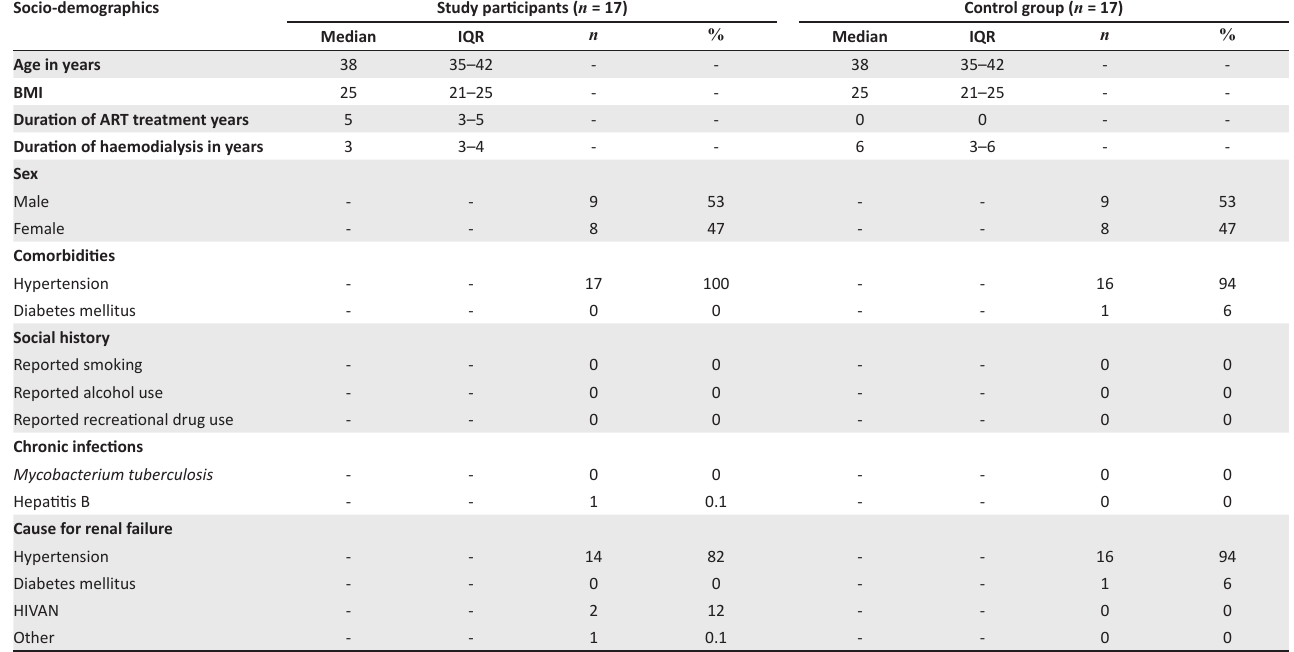
TABLE 2: Socio-demographic and categorical variables of the study participants. Socio-demographics